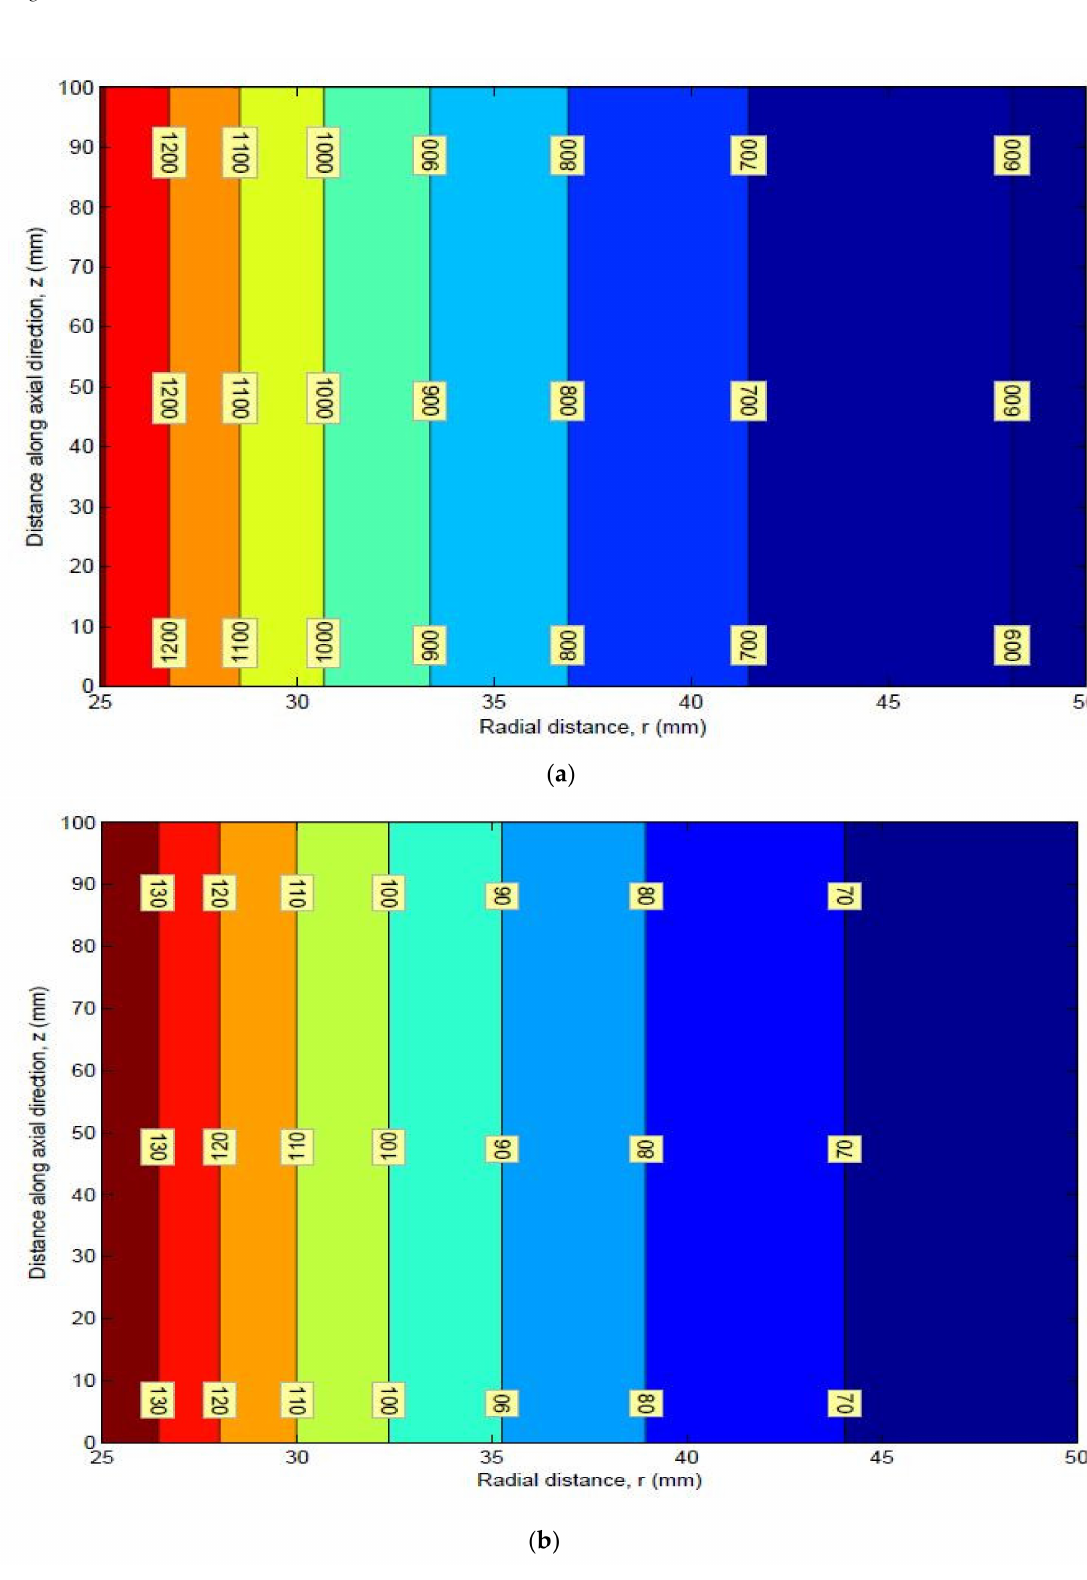
Figure 22. ( a ) Mean and ( b ) standard deviation of circumferential